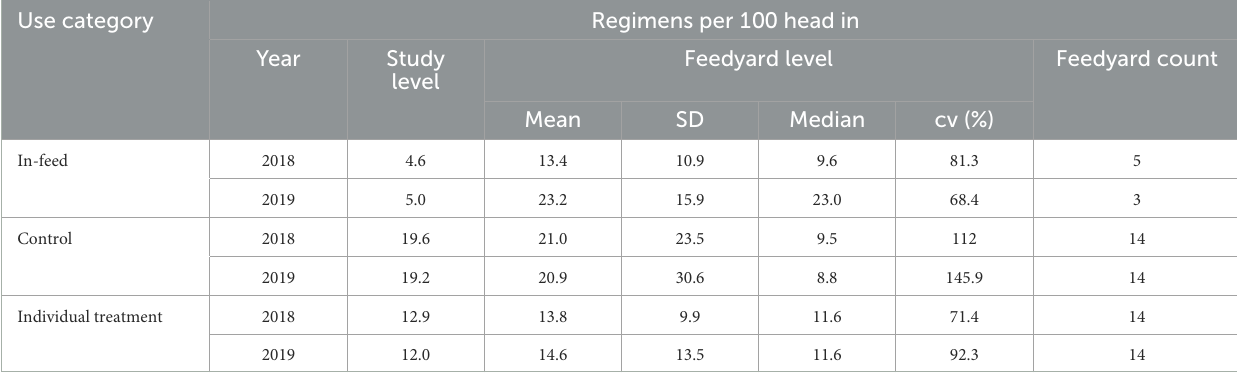
TABLE 9 Medically important antimicrobial regimens per 100 head in for bovine respiratory disease allocated to in-feed (chlortetracycline), control of bovine respiratory disease at processing, and individual animal treatment. Use